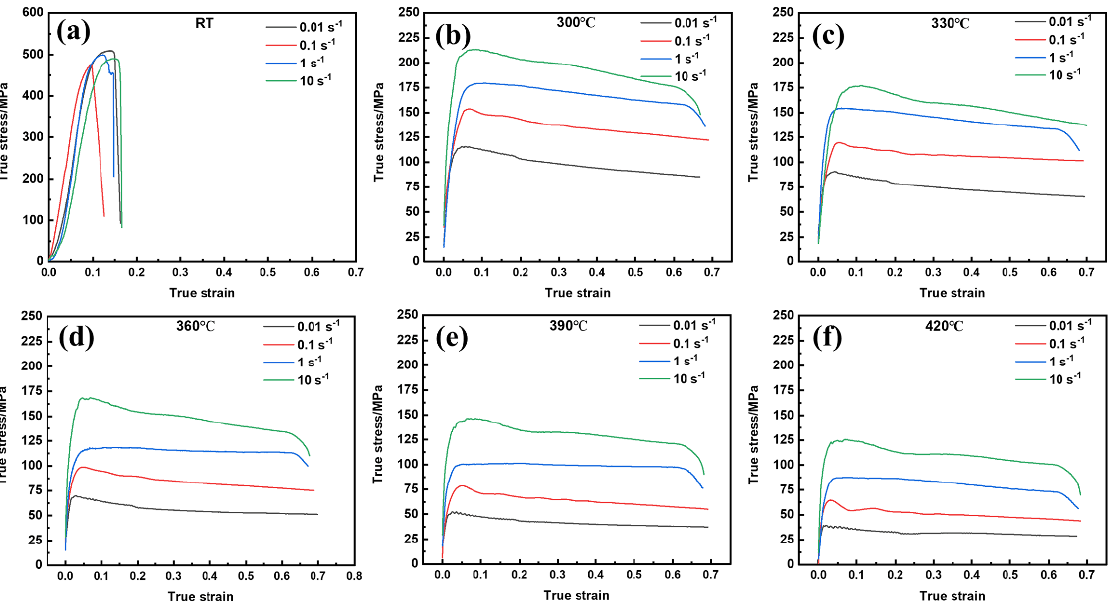
Figure 5. The true compressive stress – strain curves for the 13Zn alloy with strain rates from 0.01 s −1 – 10 s −1 at different temperatures ( a ) RT; ( b ) 300 °C; ( c ) 330 °C; ( d ) 360 °C; ( e ) 390 °C; ( f ) 420 °C.